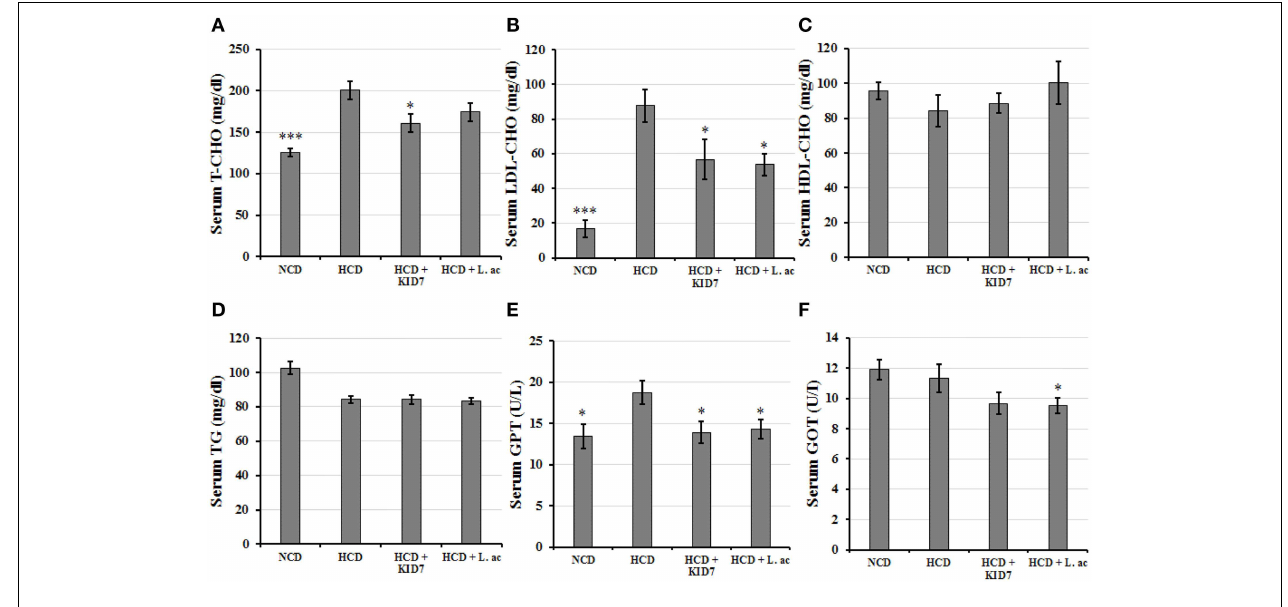
FIGURE 4 | Effects of KID7 and L. acidophilus on the serum biochemical parameters. Mice were fed either normal diet, atherogenic diet, or atherogenic diet supplemented with KID7 or L. acidophilus for 32 days. (A) T- CHO; (B) LDL-CHO; (C) HDL-CHO; (D) TG; (E) GPT; (F) GOT.